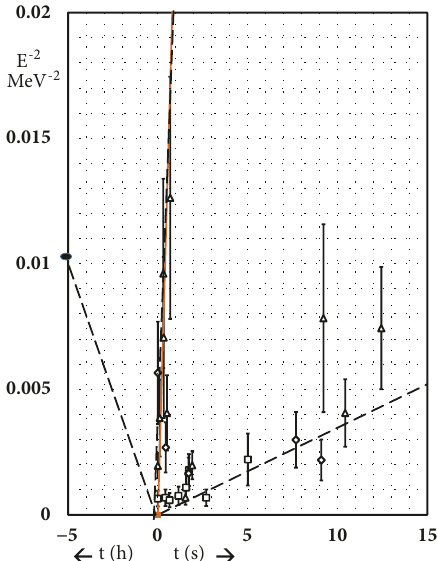
Figure 2: A plot of 1/𝐸 2 ] versus observation time for the events seen in the four neutrino detectors operating at the time of SN 1987A: open diamonds (5 Baksan events), open squares (12 Kamiokande-II events), and open triangles (8 IMB events). The single dot near t = - 5h shown without error bars represents the 5 Mont Blanc events. The dashed positive sloped lines correspond to masses 𝑚 1 = 4.0 eV and 𝑚 2 = 21.4 eV according to (2). The 3+3 model called for a third mass 𝑚 3 that was a tachyon, but it initially explicitly rejected the idea that the 5 Mont Blanc events defined one, as discussed in the